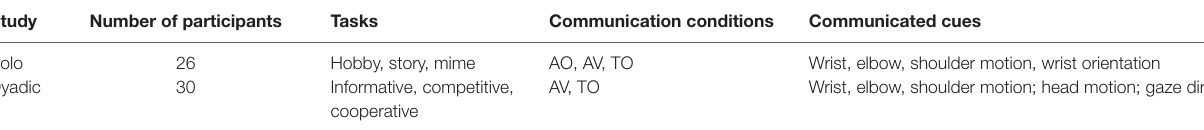
TaBle 1 | summary of the conducted studies.